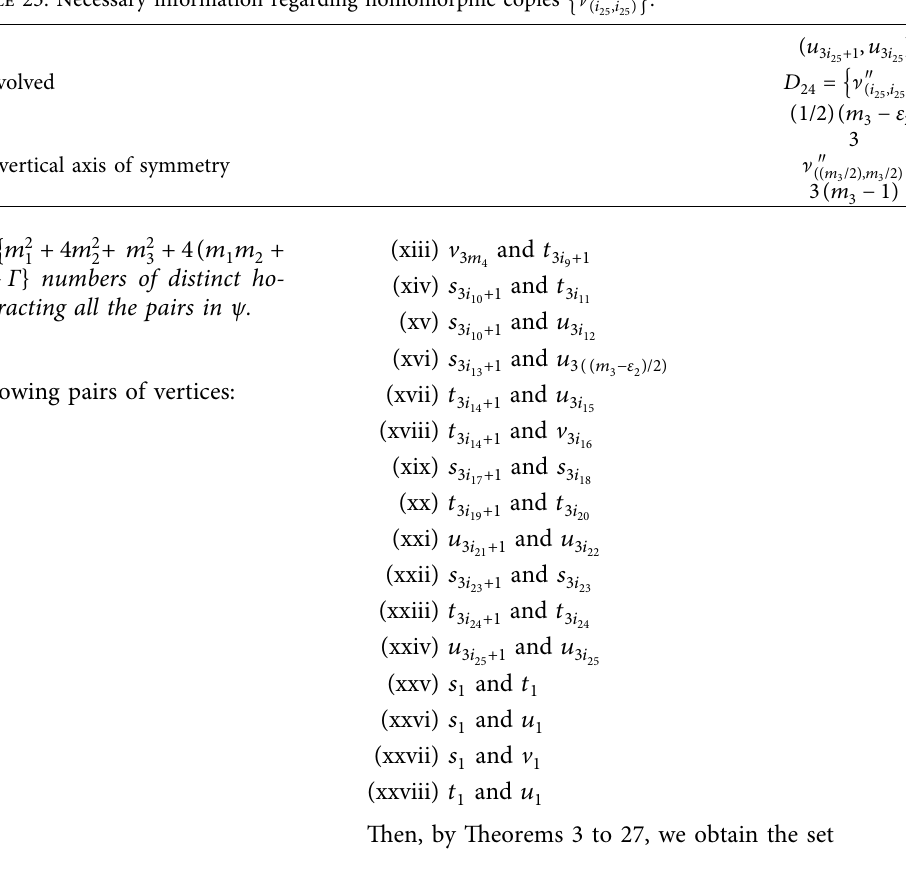
Table 23: Necessary information regarding homomorphic copies ]